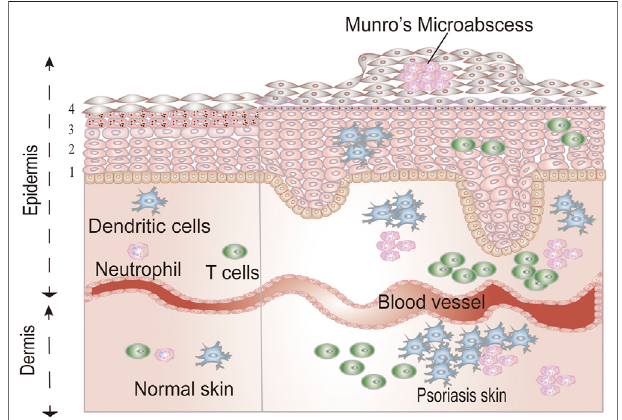
FIGURE1| The differences betweennormal skin and psoriatic skin. The epidermis contains four homogenous layers: stratum basale (1), the stratum spinosum (2), the stratum granulosum (3), and the stratum corneum (4).